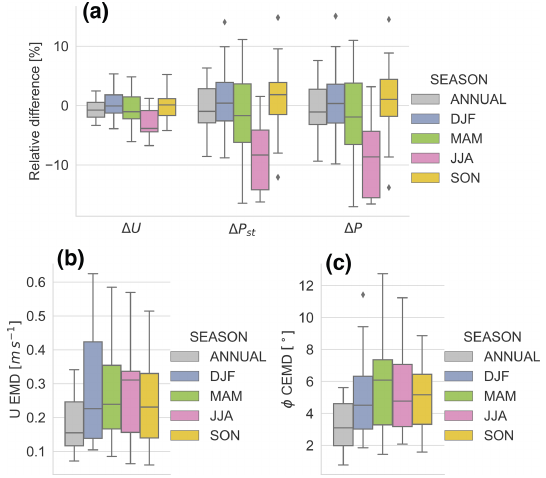
Figure 11. (a) Boxplot of the relative mean changes between the past (1995–2014) and the future (2031–2050) averaged over the North Sea box in Fig. 1a in 100ma.g.l. wind speed ( (cid:49)U ), standard wind power density ( (cid:49)P ST ), and wind power density ( (cid:49)P ). Box- plot of the changes in distribution between the past (1995–2014) and the future (2031–2050) as (b) wind speed EMD and (c) wind direction CEMD. The boxes show the spread among the 16 CMIP6 models (excluding MIROC).